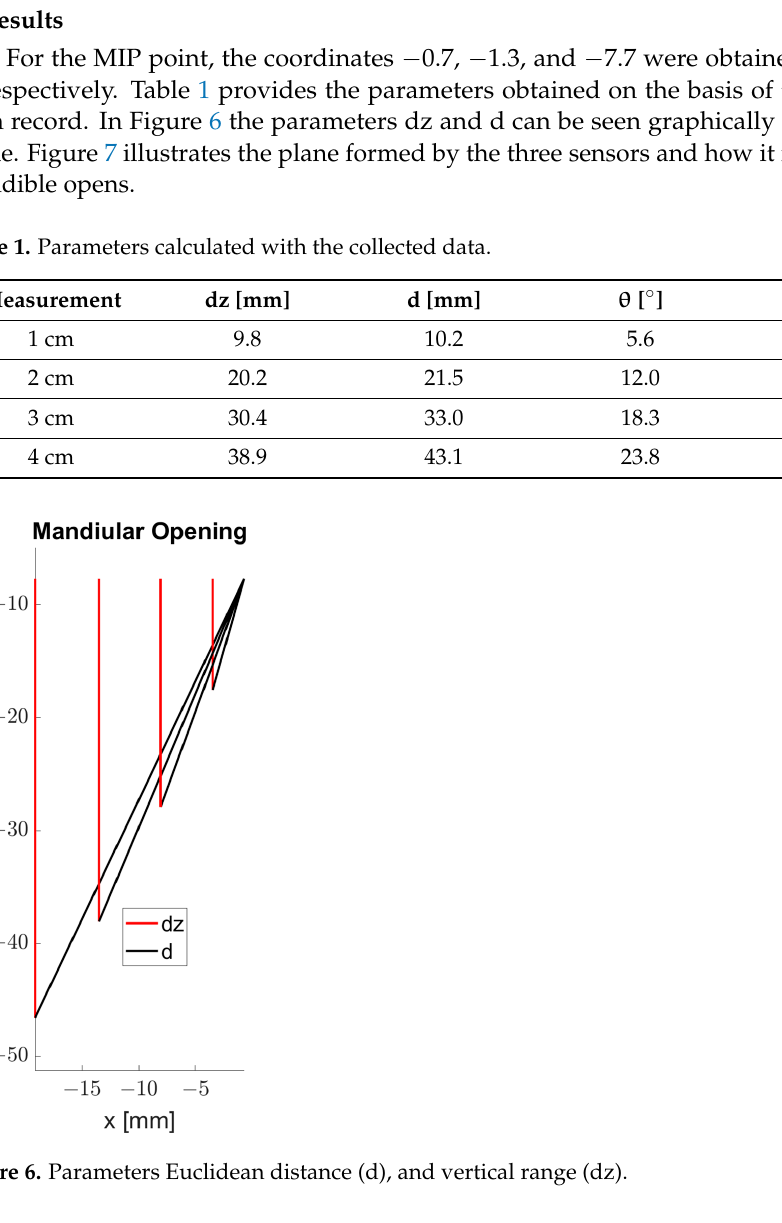
Figure 7. 3D visualization of the plane formed by the three active sensors. The incline of the plane in each measurement is observed. With the second series of records, the trajectory (T) made by the mandible of the phantom was calculated and the outline of the interincisal sensor was visualized (Figure 8).